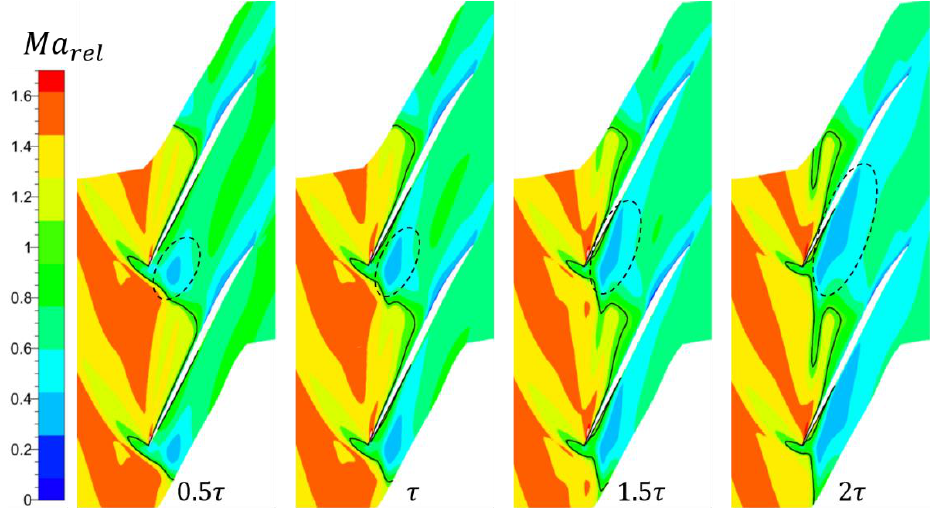
10 of 20 Figure 10. Absolute vorticity contours of rotor passage tip region at P1. A comparison of the relative Mach number ( 𝑀𝑎 𝑟𝑒𝑙 ) distribution of a rotor blade tip plane for different rotor tip clearances at the P1 condition is shown in Figure 11. The TLV/passage shock wave interaction leads to a low-velocity region surrounded by a black ellipse downstream of the shock wave, which seriously blocks the passage and worsens